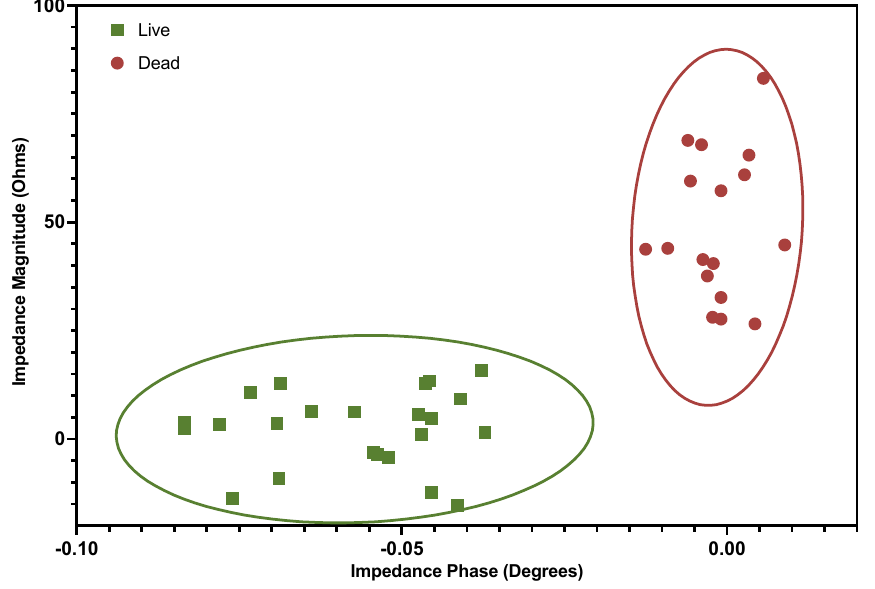
Figure 8. Representative showing that Jurkat cell viability status can be discriminated using the de- signed microchip device with impedance measurements at 2 MHz by plotting impedance components magnitude and phase against one another. Ellipses indicate 95% confidence